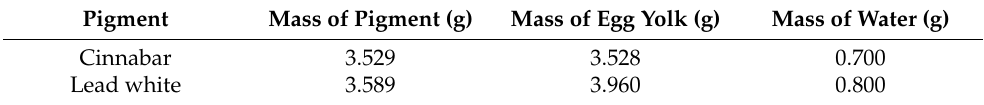
Table 1. Mass of pigments, egg yolk and water used in mock-up preparation. Pigment Mass of Pigment (g) Mass of Egg Yolk (g) Mass of Water (g) Cinnabar 3.529 3.528 0.700 Lead white 3.589